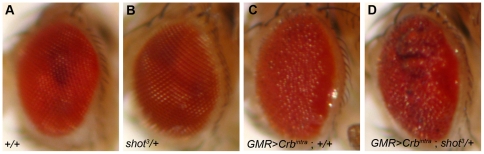
Genetic interactions between crb and shot in Drosophila eye.(A–B) Adult eye phenotypes of+/+(A), shot3/+(B), GMR>Crbintra;+/+(C), and GMR>Crbintra; shot3/+(D).